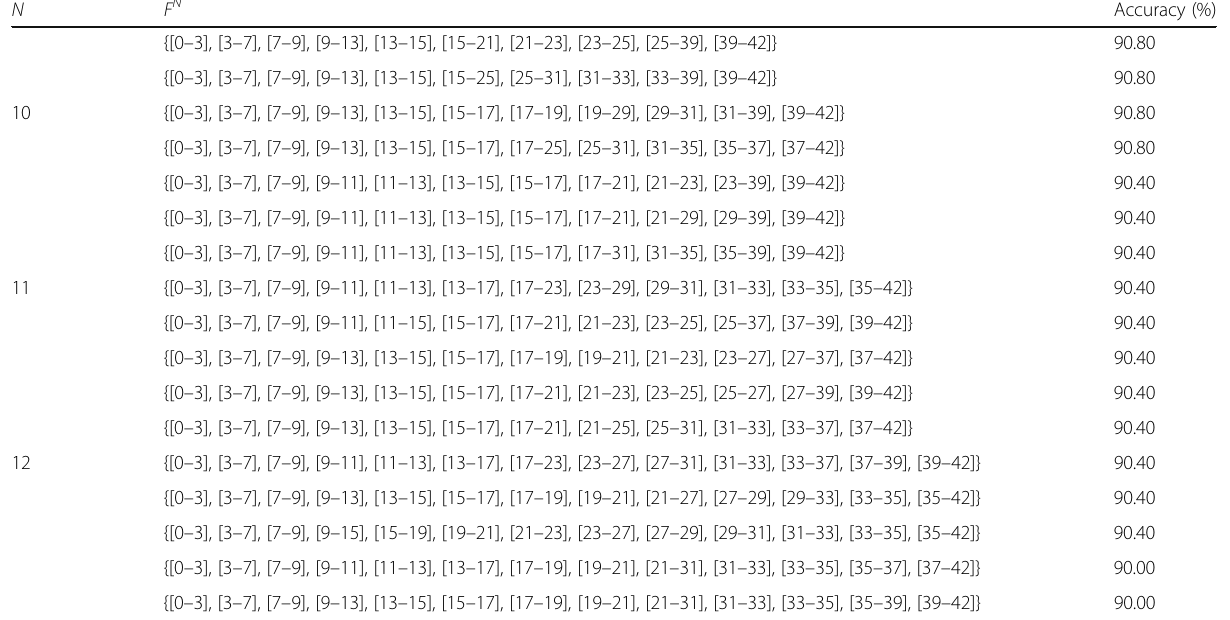
Table 5 Top 5 accuracy results for the five-class problem and the respective frequency sub-bands ( F N ) (Continued) N